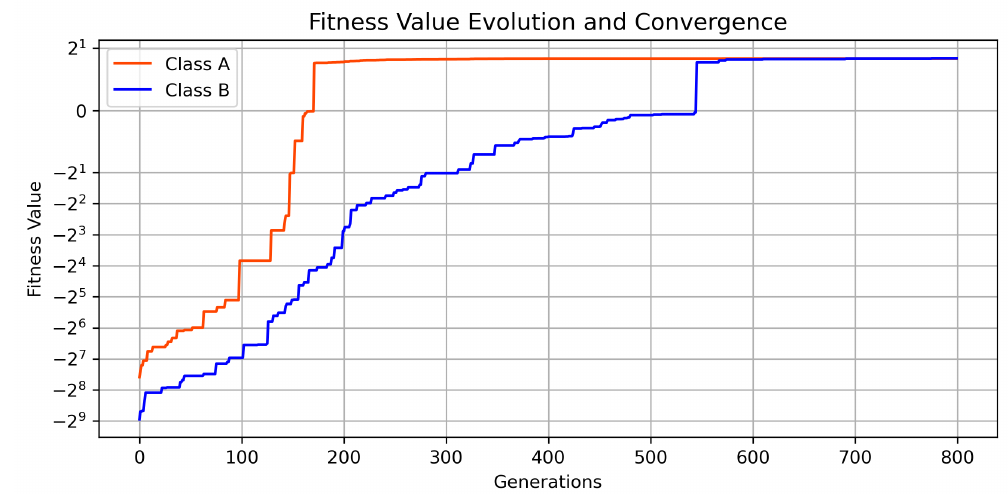
Figure 6. Evolution of the GA optimization for both scenarios and convergence to the final solution. Class B requires additional generations to obtain an adequate solution, due to the restrictive limitations of the scenario. The rapid increase in fitness value for both functions when surpassing the 0 axis is due to the change in the fitness evaluation technique.